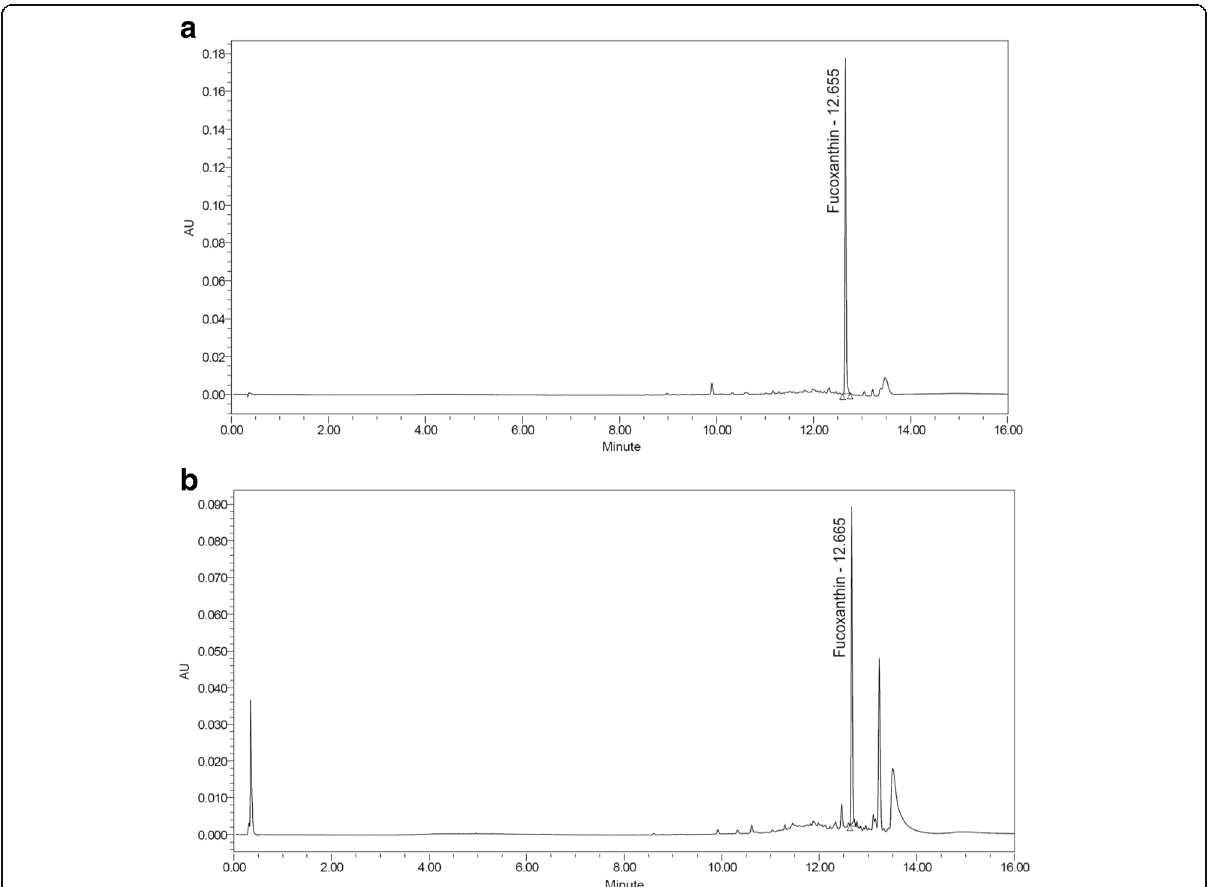
Fig. 6 UPLC chromatogram of fucoxanthin standard ( a ) and fucoxanthin in L. japonica ( b ). The peak represents fucoxanthin (330 nm)